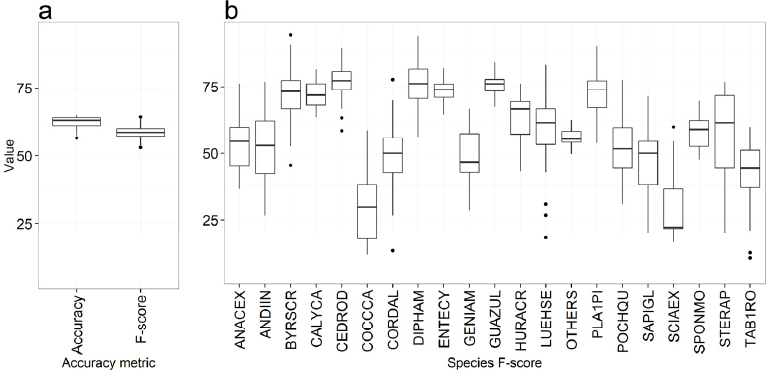
Figure 3. Model and species-level accuracy metrics of a 21-class SVM model ( a ) Model-level metrics of percent overall accuracy and F-score; ( b ) species-level F-score. Both plots show values across 30 model iterations. Full species names for each species code are given in Table 2.